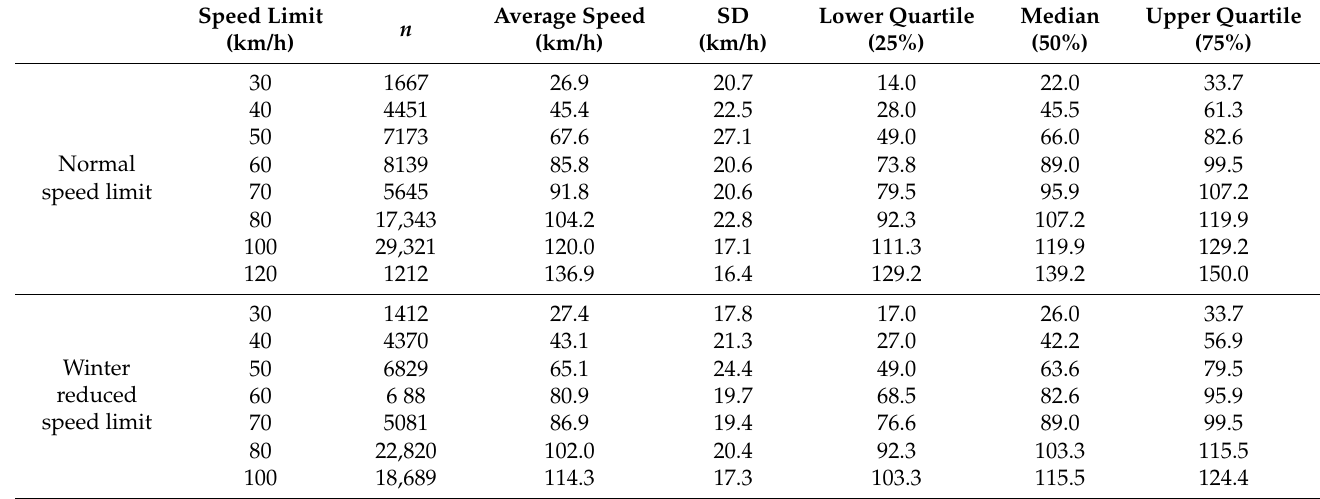
Table 1. Registered driving speeds by road speed limit in the urgent ambulance A-mission group.